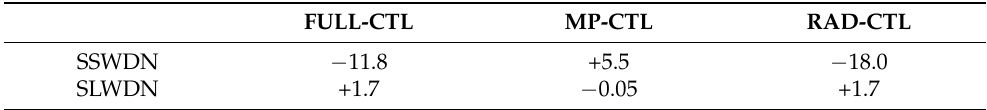
Table 9. Area average (wgt_areaave) of the mean downwelling long/shortwave at the surface. Units are W m − 2 . FULL-CTL MP-CTL RAD-CTL SSWDN − 11.8 +5.5 − 18.0 SLWDN +1.7 − 0.05